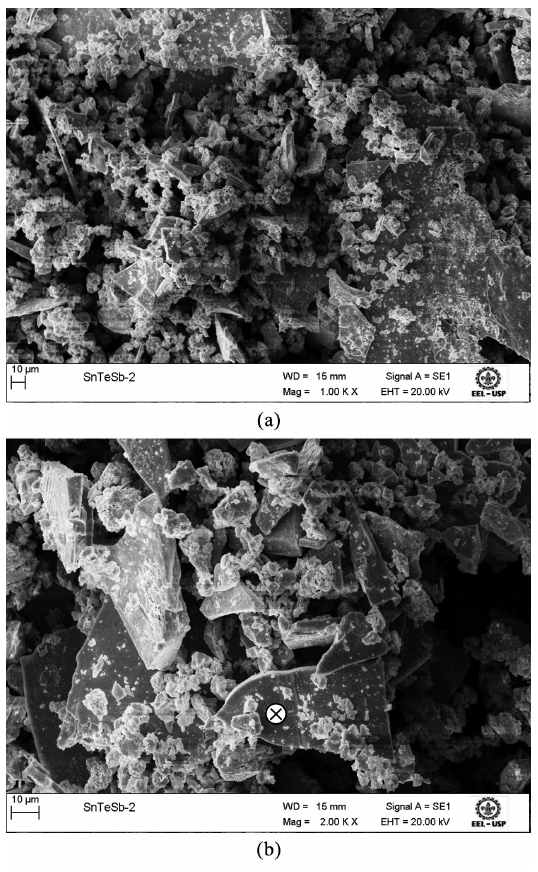
Figure 3. Details of SnSb